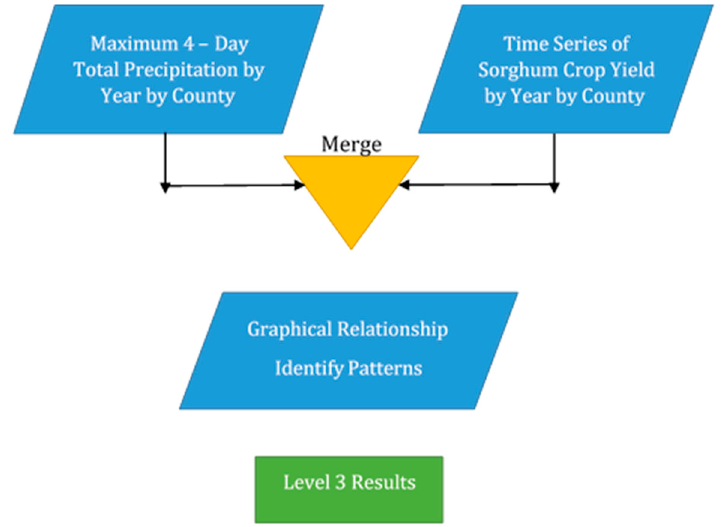
Figure A2. Generation of the graphical relationship between rainfed sorghum yield and maximum 4–day total precipitation (level 3 results).